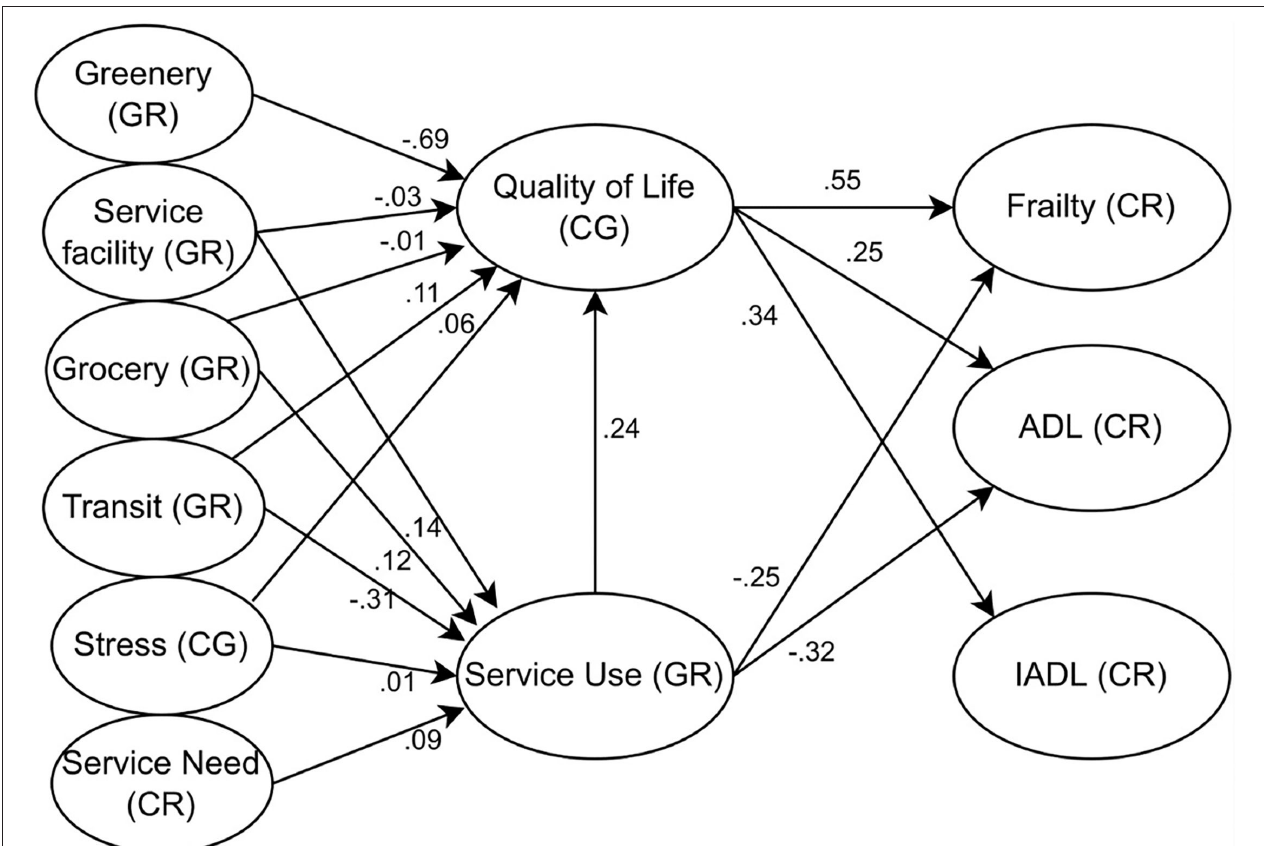
FIGURE 3 | Statistical model. CG, caregiver; CR, care recipient/frail older adults; GR, both frail older adults and caregivers.